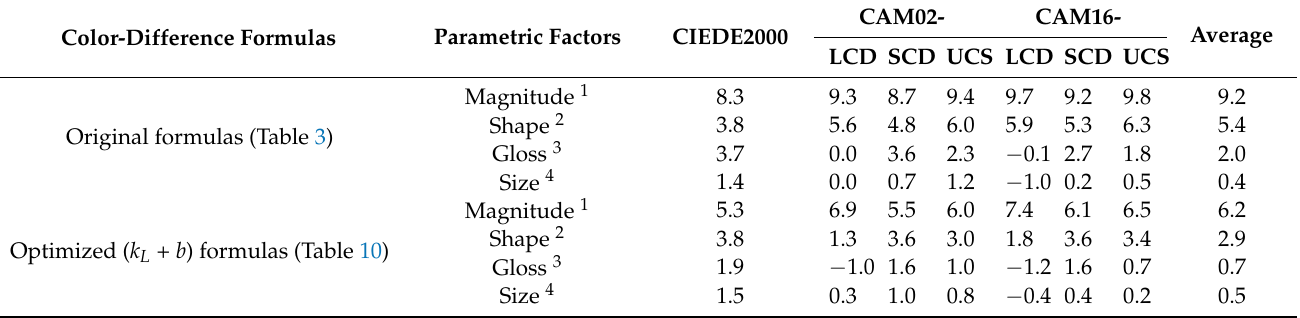
tude, shape, gloss, and size of 3D samples (Table